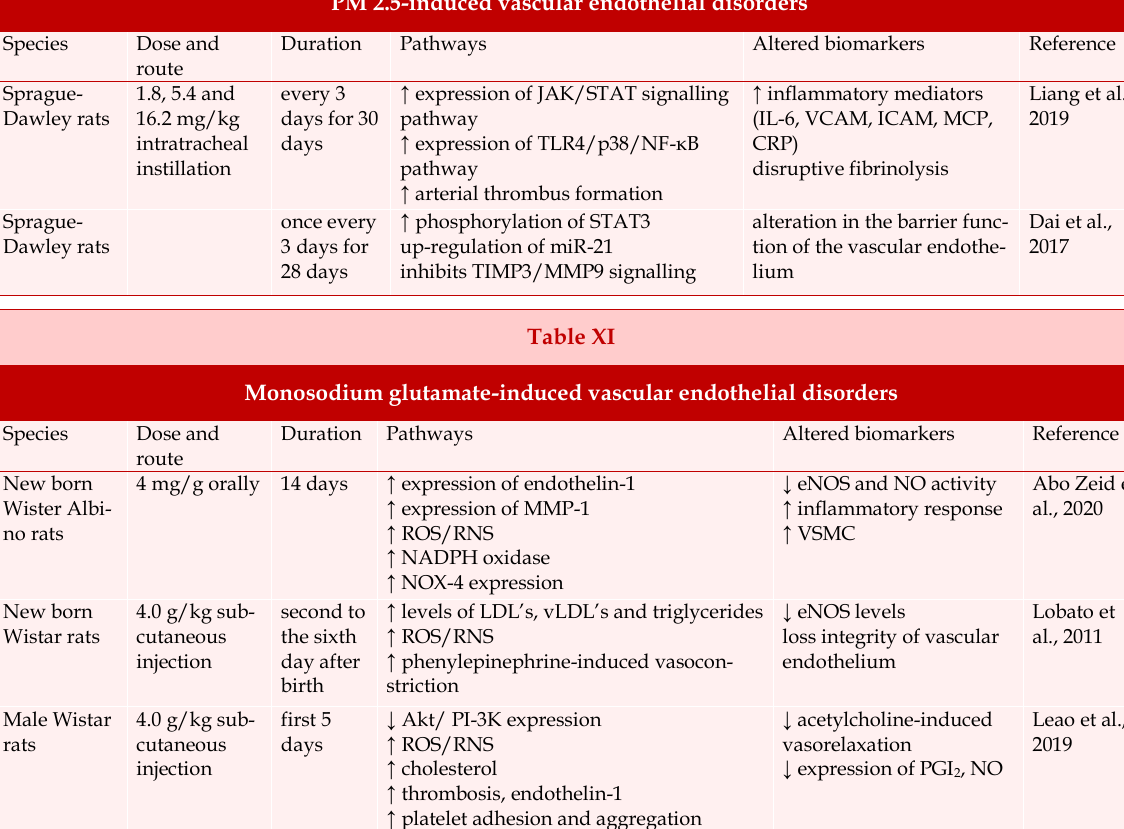
PM 2.5-induced vascular endothelial disorders